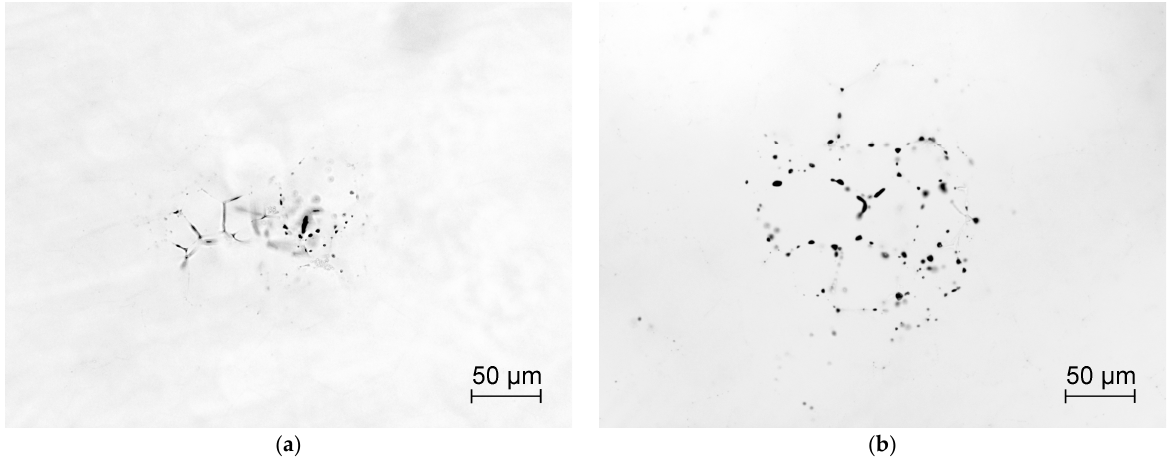
Figure 7. Examples of pore clusters in ceramics ( a ) after hot pressing and ( b ) after HIP. Table 1. Number of pore clusters in the area Ø5 mm in yttria ceramics obtained from precursors of different compositions. Precursor Composition, ϕ . Number of Pore